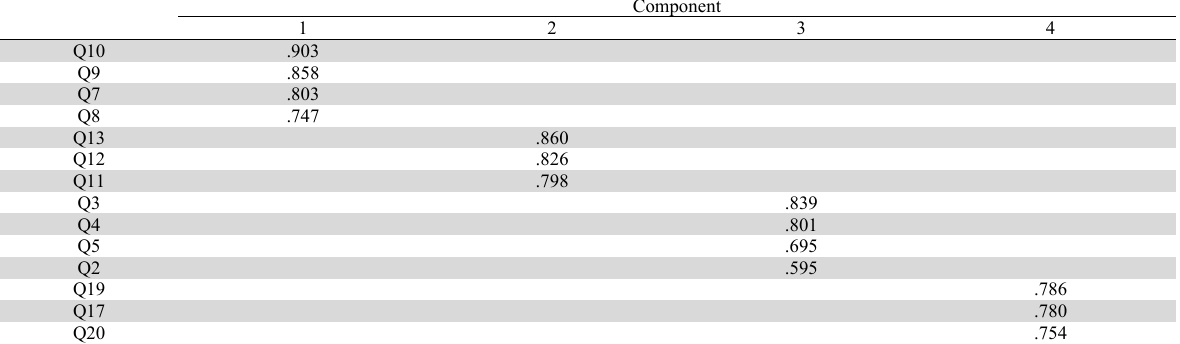
The results of rotated component